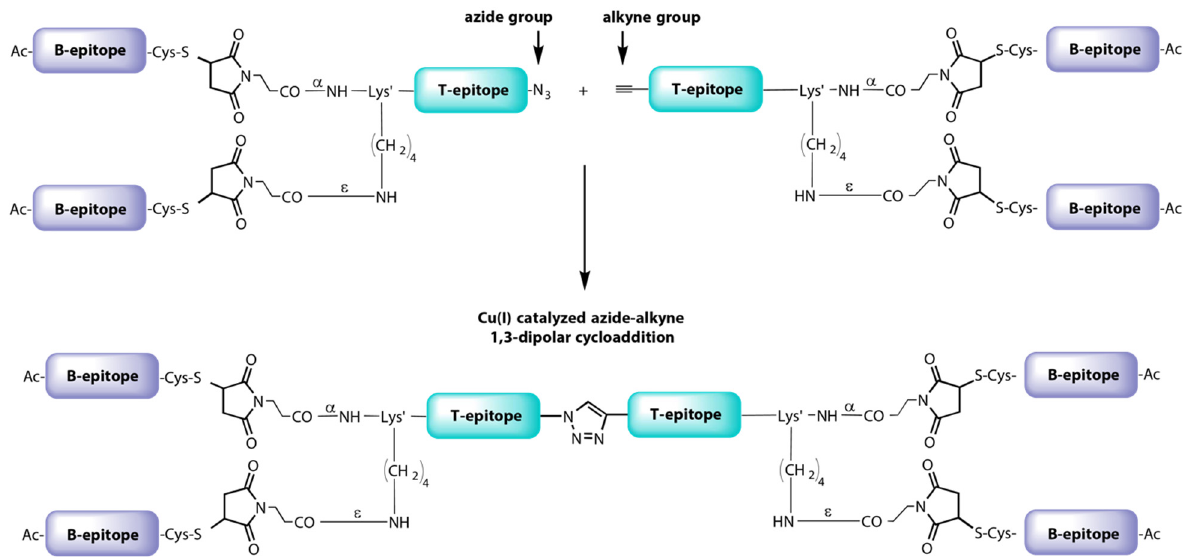
Figure 7. Synthetic scheme of B 2 T-TB 2 vaccine prototype against